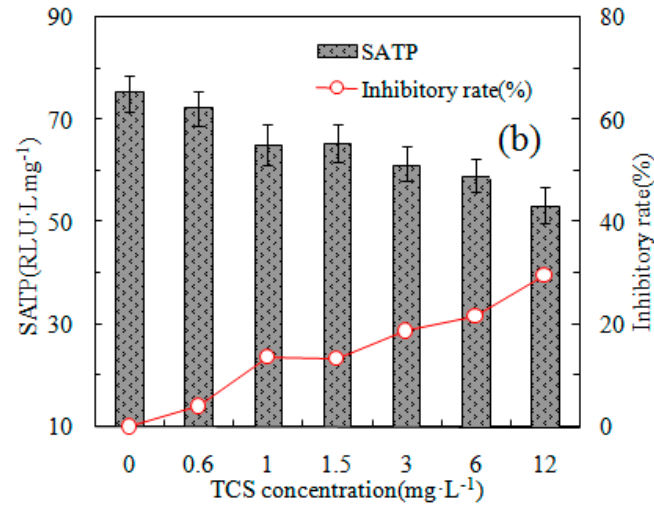
Figure 3. ( a ) The changes in and the inhibitory rates of TTC-ETS at different TCS concentrations; and ( b ) the changes in SATP caused by different concentrations of TCS addition.